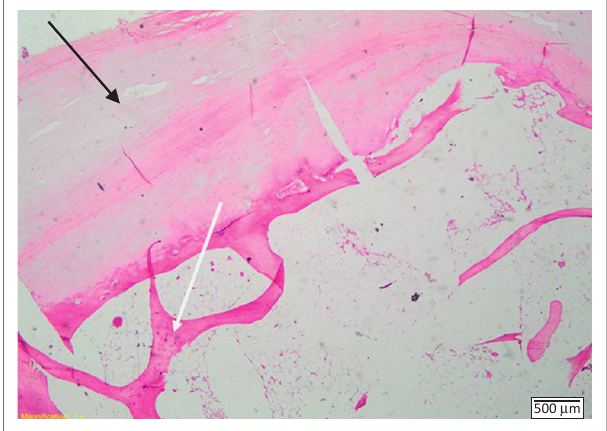
FIGURE 4: Haematoxylin and eosin staining, X 100 magnification. Hypocellular cartilaginous lesion comprising chondrocytes (black arrow) with minimal cytological atypia. The chondrocytes are arranged in vague columns. In deeper layers, the chondrocytes enlarge with more abundant